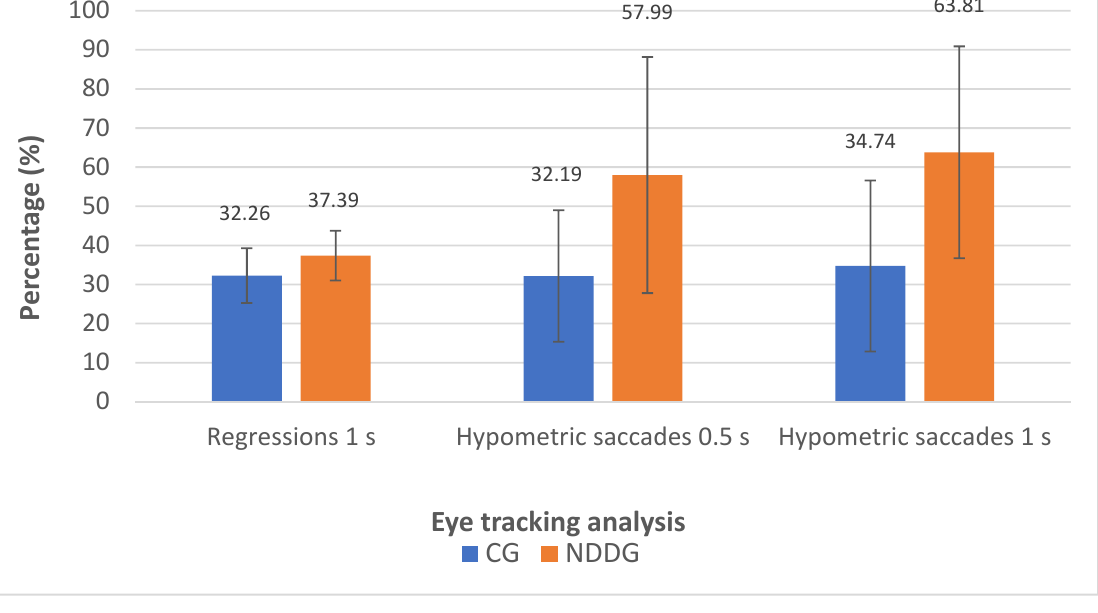
Figure 3. Diagram showing the statistically significant differences found between control group (CG) and neurodevelop- mental disorder group (NDDG) in the percentage of regression detected with the eye tracker using a time interval of presentation of stimuli of 1 s as well as in the percentage of hypometric saccades detected using time intervals of 0.5 and 1 second.